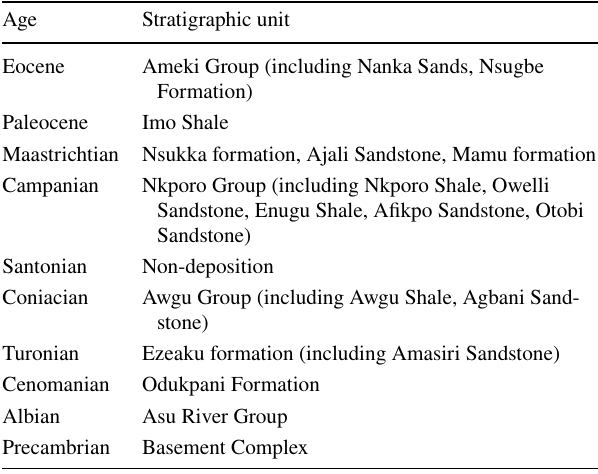
Table 1 Stratigraphy of the Anambra basin (Nfor